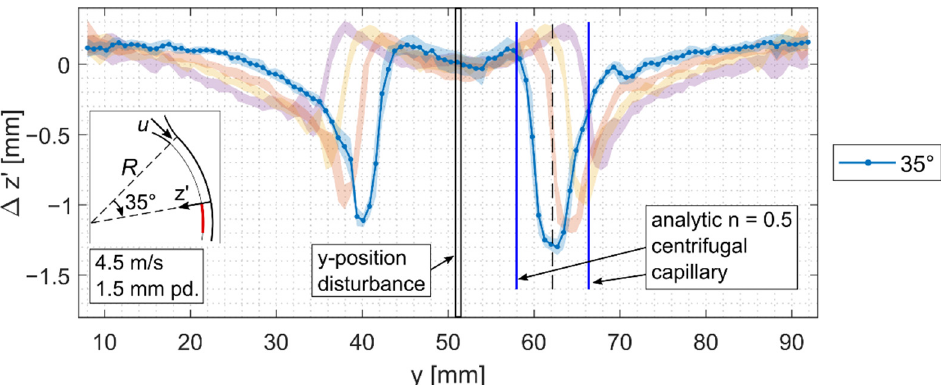
Figure 8. Comparison of the measured wake position with the predicted position of the analytical solutions β = 35° downstream of the nozzle. The profiles at the other positions of β from Figure 7 are still indicated in the background as reference (red, yellow and purple).